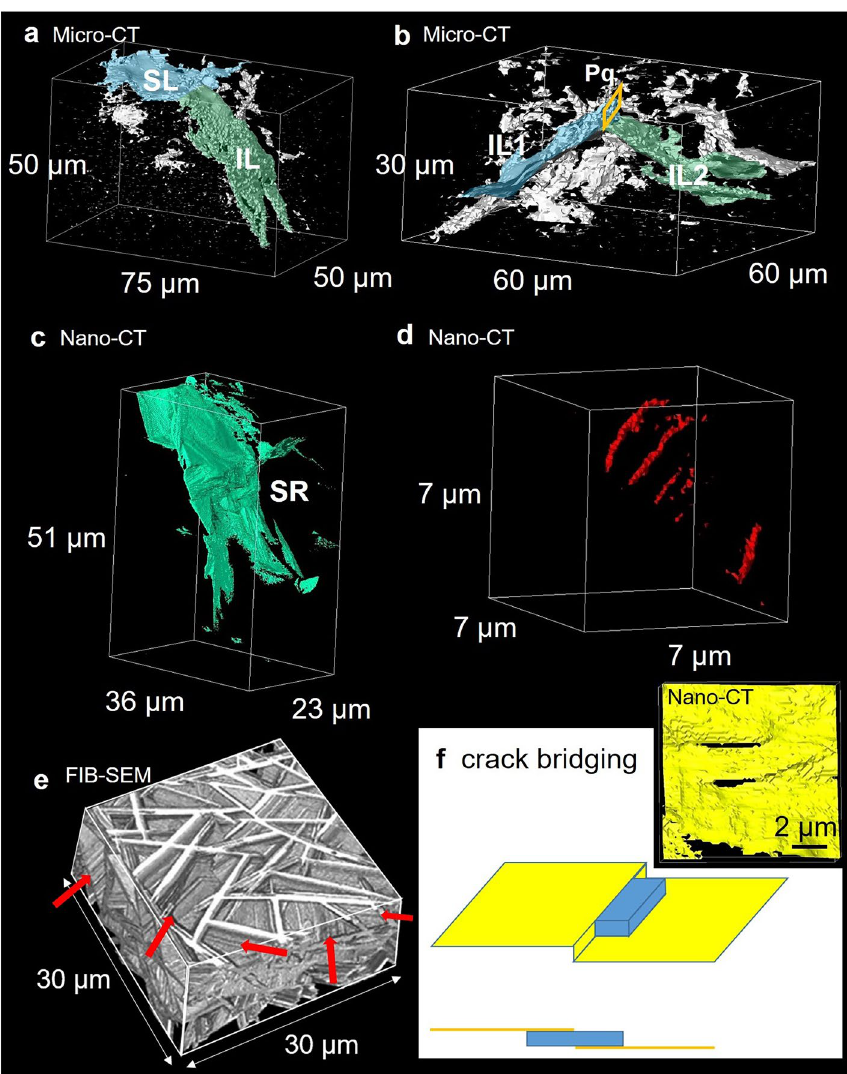
Figure 6. Components of indentation crack system. ( a ) Combined crack consisting of a shallow lateral crack (SL) and an inclined lateral crack (IL) in Fig. 5a, ( b ) combined crack consisting of a surface localized radial crack (Palmqvist crack, Pq) and two inclined lateral cracks (IL1, IL2) in Fig. 5a, ( c ) secondary radial crack (SR) in Fig. 5a,b, ( d ) parallel ribbon-like cracks in Fig. 5c (red arrows), ( e ) the house-of-cards structure of h-CAS crystals observed by FIB-SEM tomography, ( f ) two rectangular holes on secondary radial crack (SR) in Fig. 5d and a crack bridging model of a platelet located parallel to crack